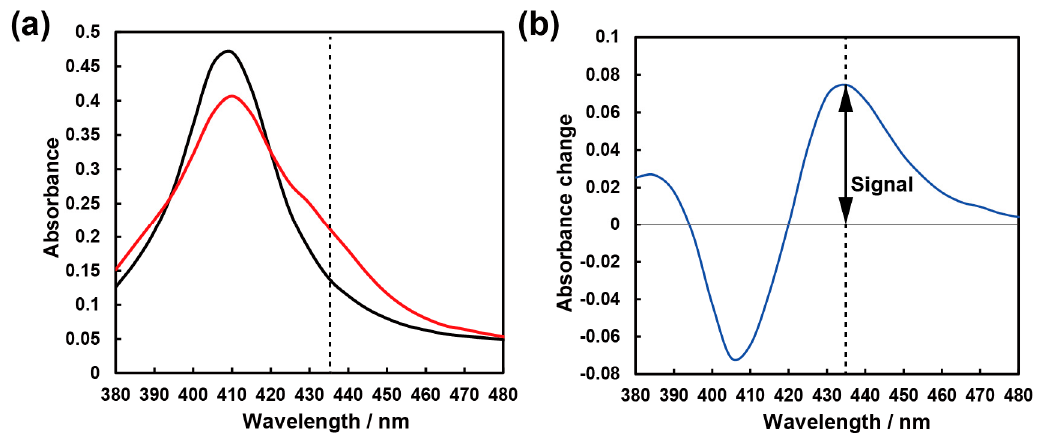
Figure 3. ( a ) Absorption spectra of the CoTPP-EC film before and after exposure to 10 ppm nitrogen oxide (NO) / N 2 gas in low humidity (~0%RH). ( b ) Subtraction of the absorption spectra before and after exposure to 10 ppm NO / N 2 gas.